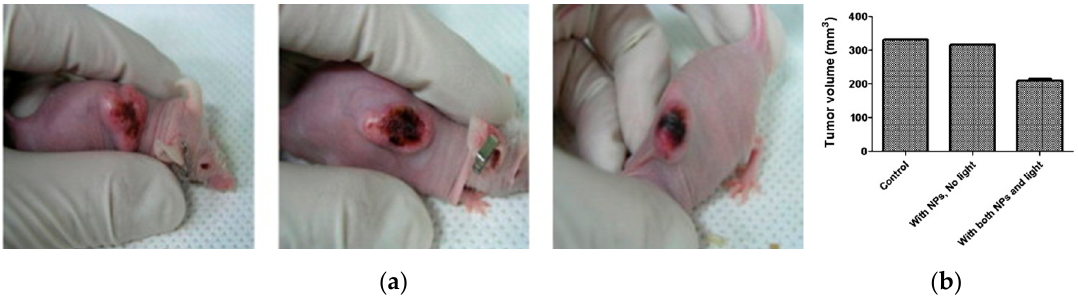
Figure 8. ( a ) Photographs of A431-heterograft tumor on mice in the absence of Ag / AgBr / TiO 2 NPs and irradiation for 10 min (left), in the presence of NPs without irradiation (middle), and in the presence of both NPs and irradiation for 10 min (right); ( b ) The measured tumor volumes (mm 3 ) for the three types of samples. Reprinted with permission (after formatting) from [139]. Copyright (2011) Elsevier.